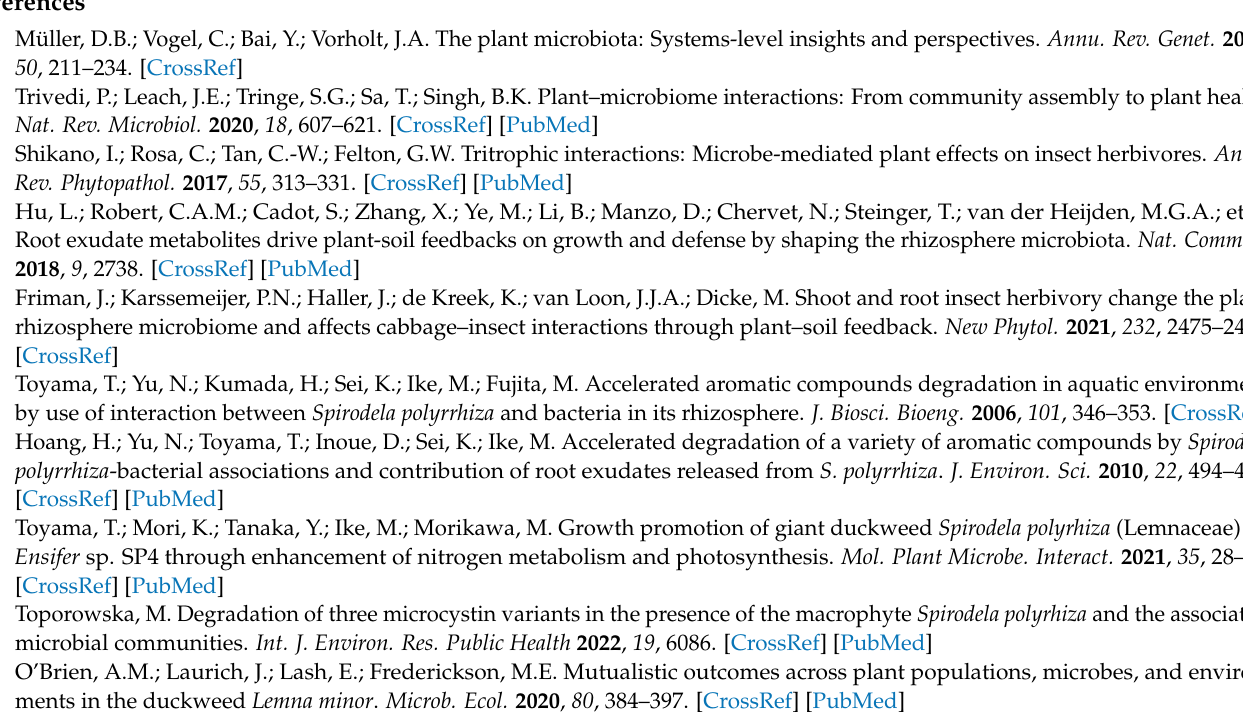
assay were treated as experimental units and the number of replicates is provided in the figure legend. For the growth assay, the genotypes SP1, SP2, SP5, SP14 and SP30 had 20 replicates, and SP9 had 16 replicates. For the tolerance and herbivore assay, SP1, SP2, SP5, SP14 and SP30 had 15 replicates, and SP9 had 11